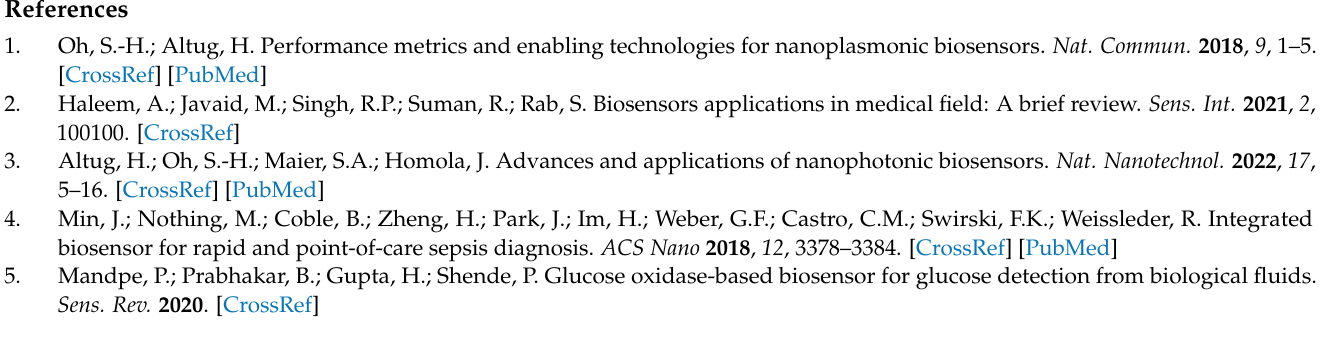
Figure 10. Lateral position shift measurement of ( a ) BSA ( b ) biotin molecules with different concen- tration levels.